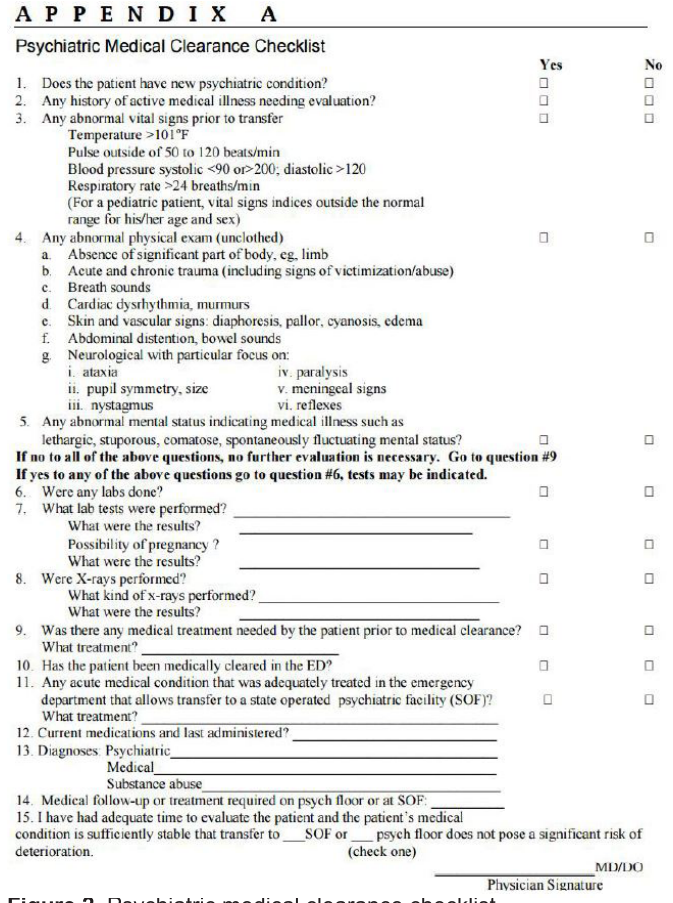
Figure 2 . Psychiatric medical clearance checklist.